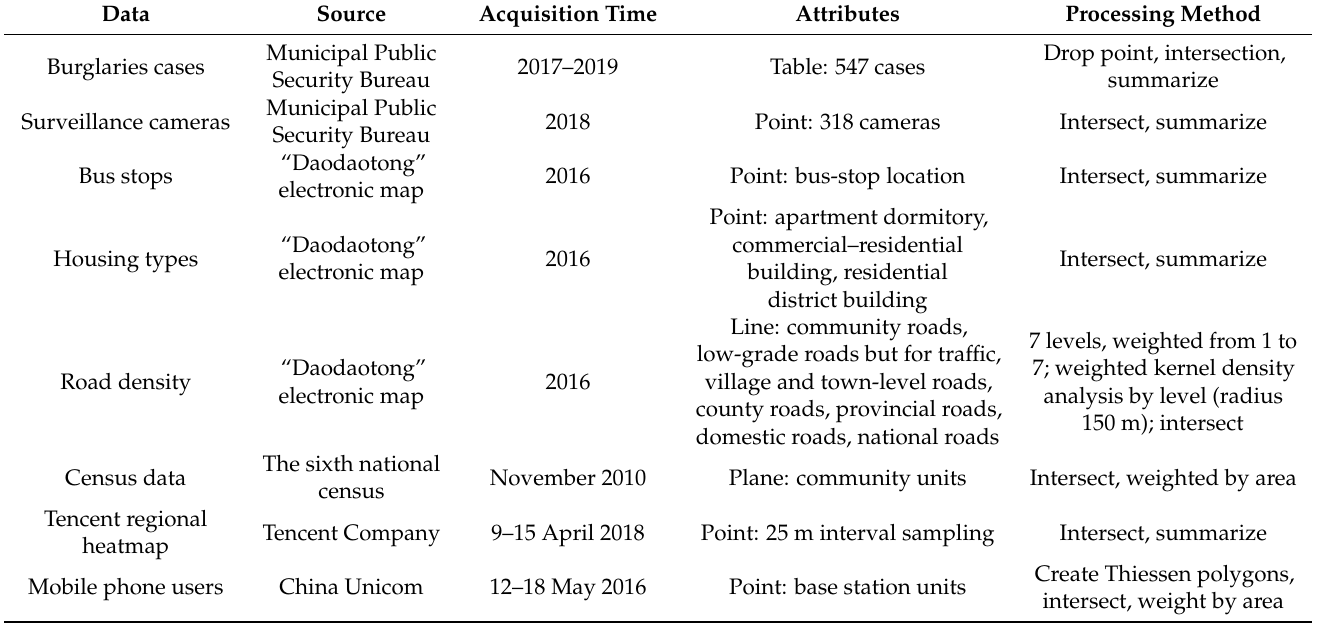
Table 2. Data overview and processing